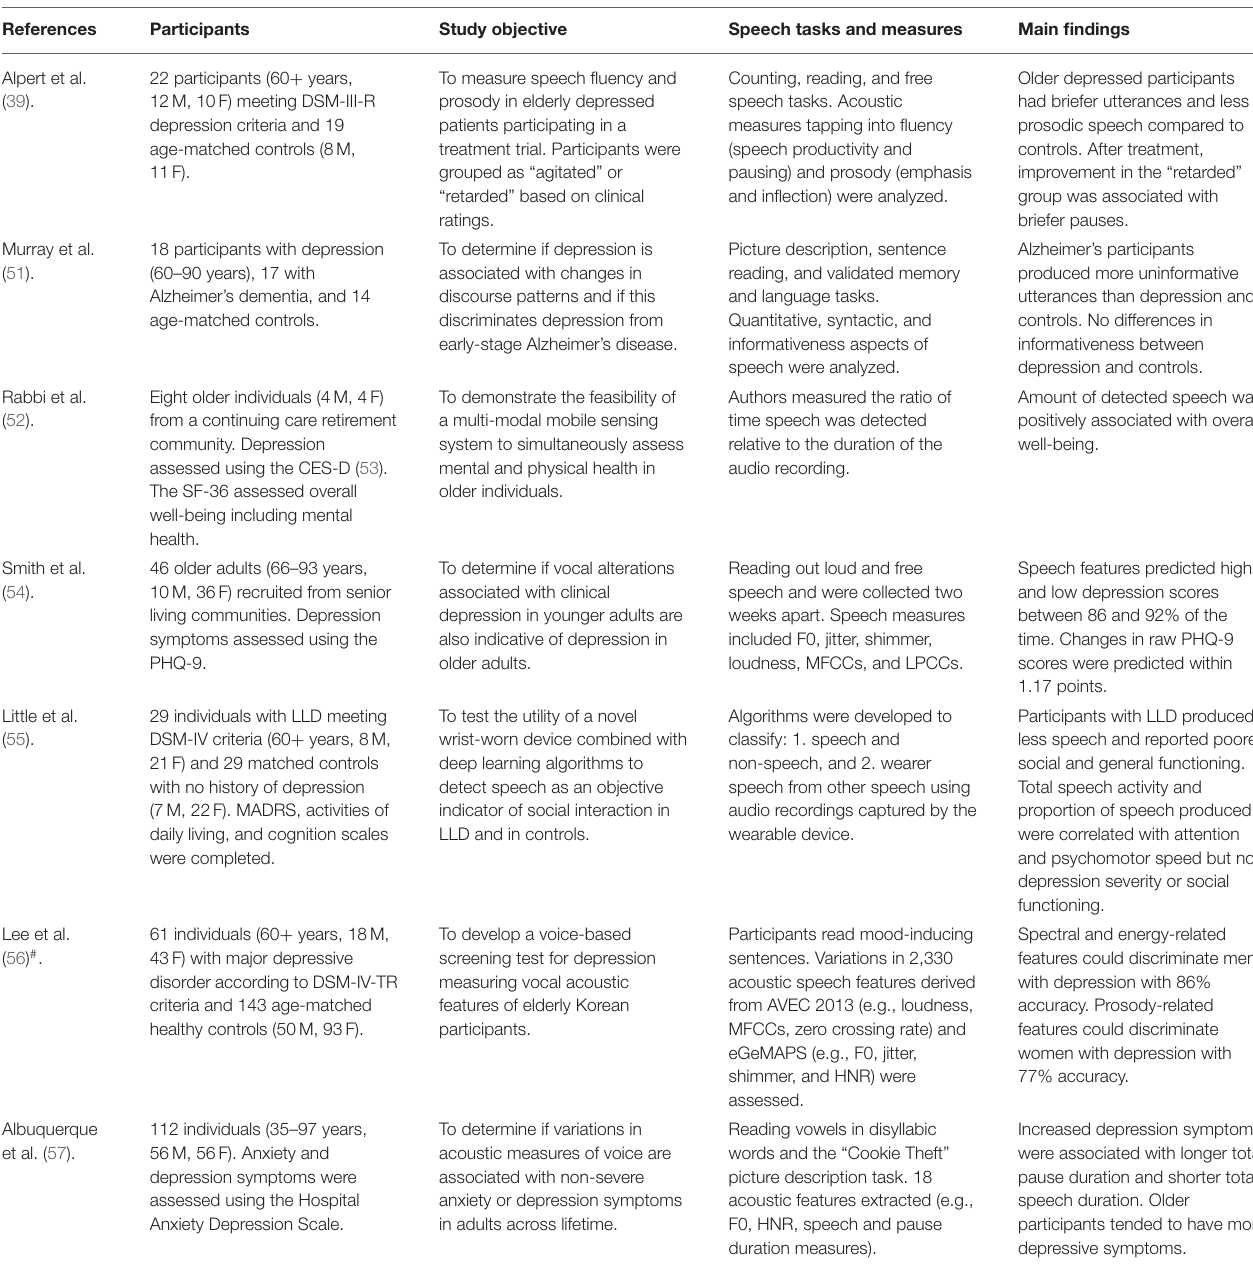
TABLE 1 | Summary of recent research examining speech in older adults with